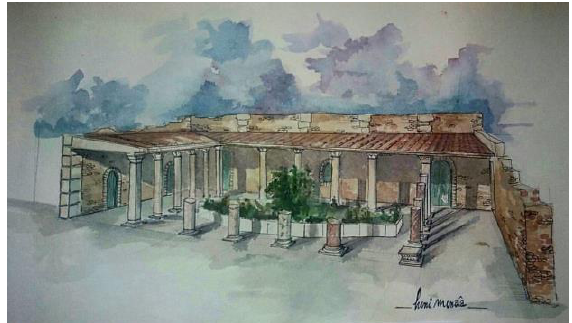
Figure 5- Perspective drawing with colors of the villa of the